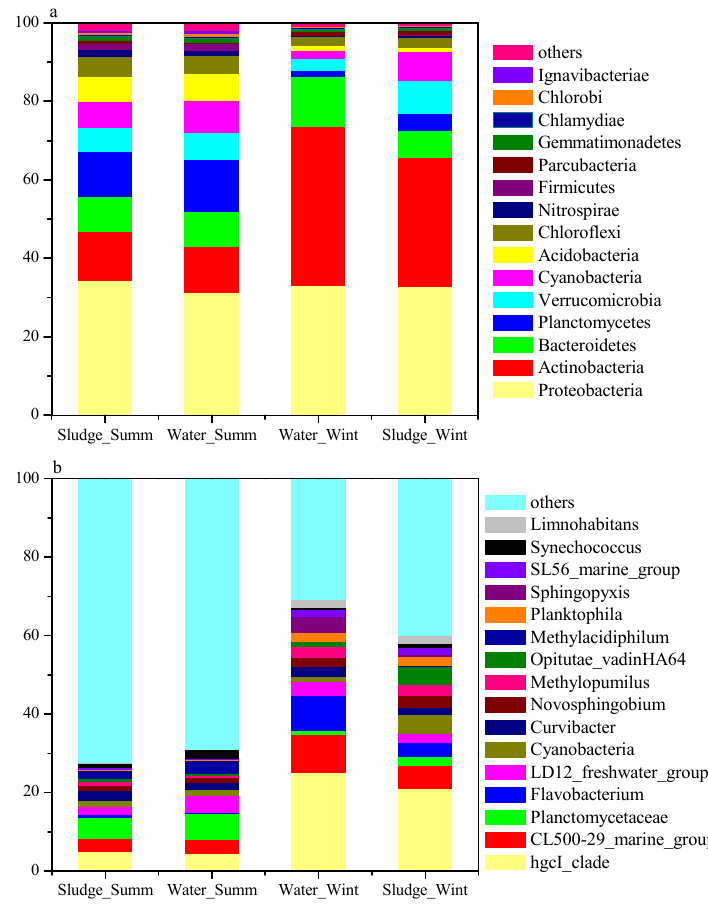
Figure 2. Microbial communities of raw water and the corresponding coagulation sedimentation sludge: ( a ) phylum level; ( b ) genus level.